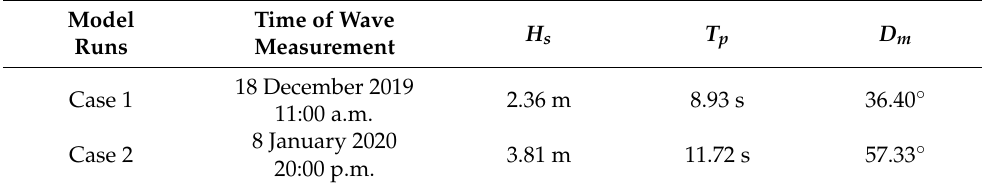
Figure 4. The unstructured grid system for TOMAWAC and ARTEMIS: ( a ) meshes around JP, with the smallest grid size of 5 m; ( b ) map of the water depths in the models based on bathymetry measurements. Table 1. List of wave parameters used as the forcing (boundary) conditions for both models in the two runs of Case 1 and Case 2. The model input data were determined based on the measurements during the field